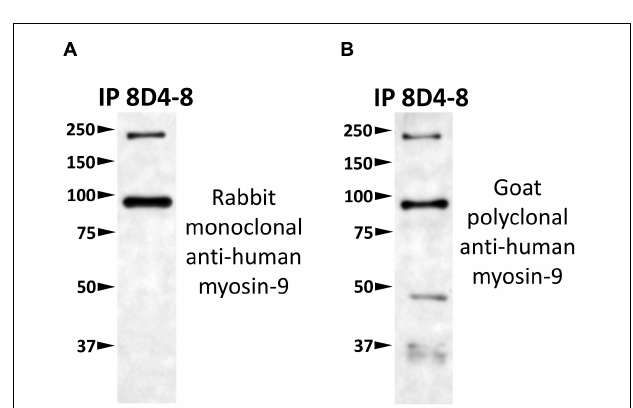
FIGURE 6 | 8D4-8 immunoprecipitates myosin-9. We western blotted equal volumes of 8D4-8 immunoprecipate and targeted with either (A) rabbit monoclonal anti-myosin-9, or (B) goat polyclonal anti-myosin-9. Both myosin-9 antibodies detected bands at ∼ 225 and ∼ 95 kD, in the size range of full length myosin-9 as well as the apoptosis-associated tail piece. Data are representative of 2 separate immunoprecipitations of control and staurosporine-treated lysates which were used for mass spectrometry